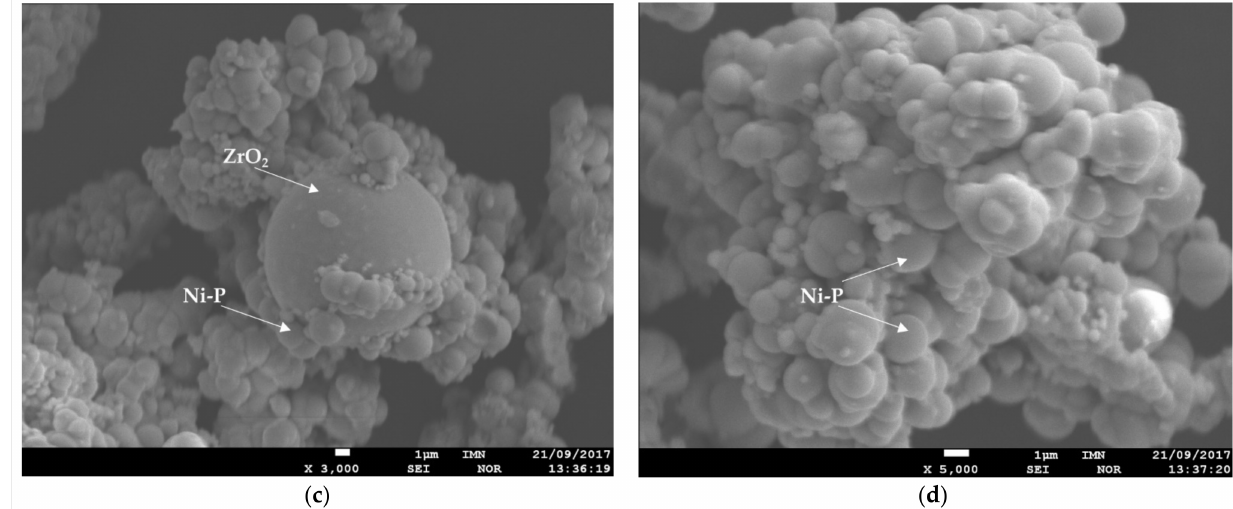
Figure 4. SEM images of surface morphology of the Ni–P–ZrO 2 composite powder, magnification: ( a ) 100 × , ( b ) 500 × , ( c ) 3000 × and ( d ) 5000 × .